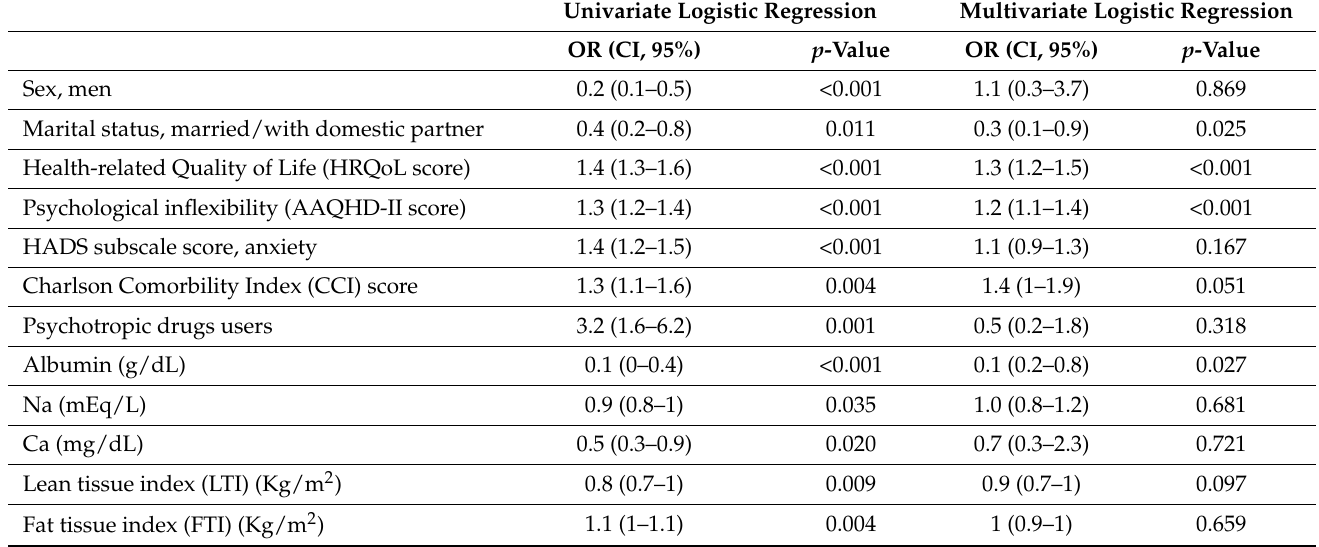
Table 3. Univariate and multivariate logistic analyses. Regression models performed to identify predictive factors for depressive state in patients on HD